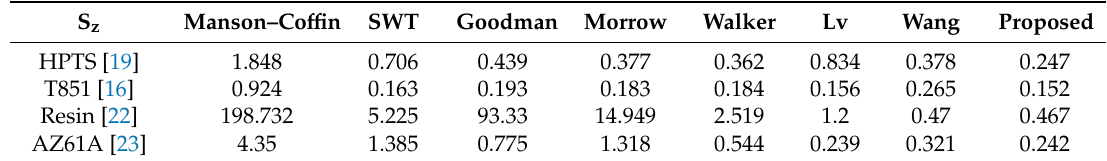
Table 1. Comparison of relative errors of di ff erent